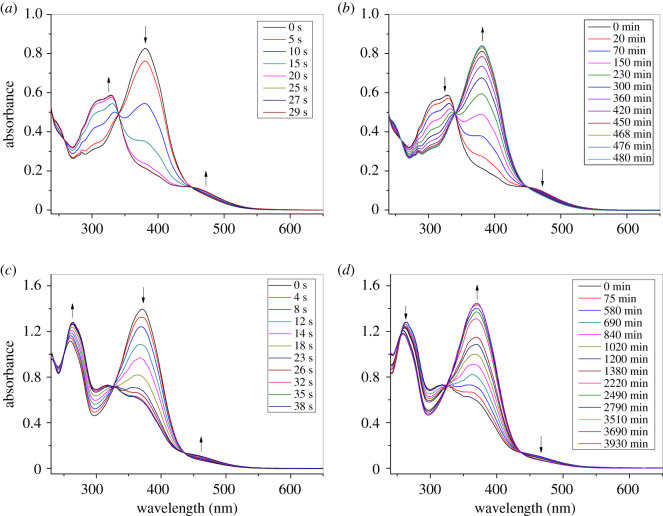
Changes of absorption spectra of 3a-14 (a,b) and 5b-14 (c,d) in CH2Cl2 during UV exposure (a,c) and thermal back relaxation (b,d).